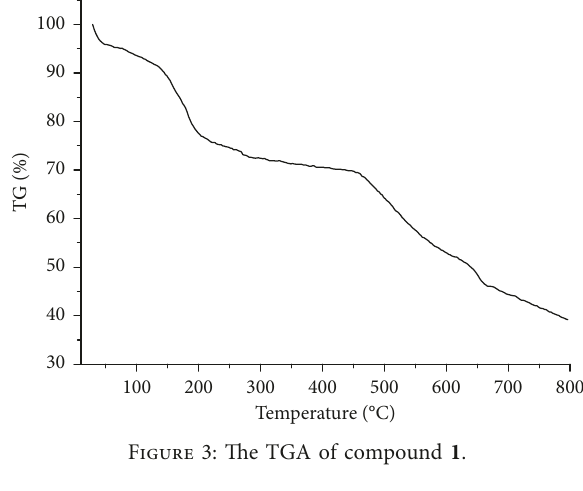
Figure 3: The TGA of compound 1 .